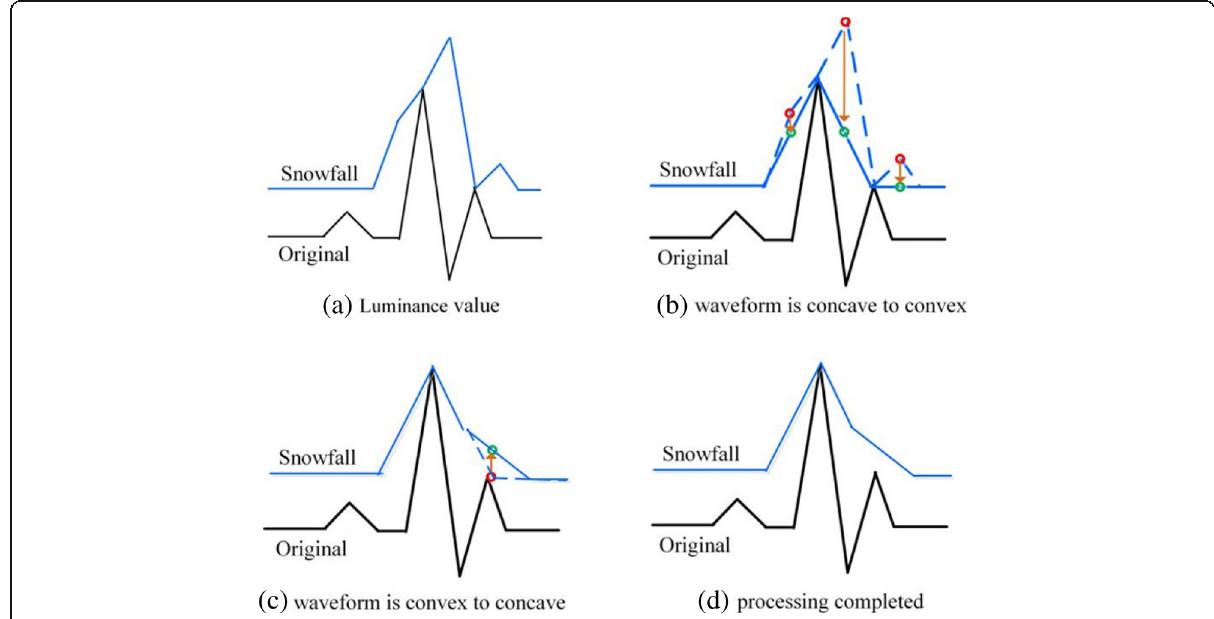
Fig. 2 Snowfall correction process. a Luminance value. b Waveform is concave to convex. c Waveform is convex to concave. d Processing